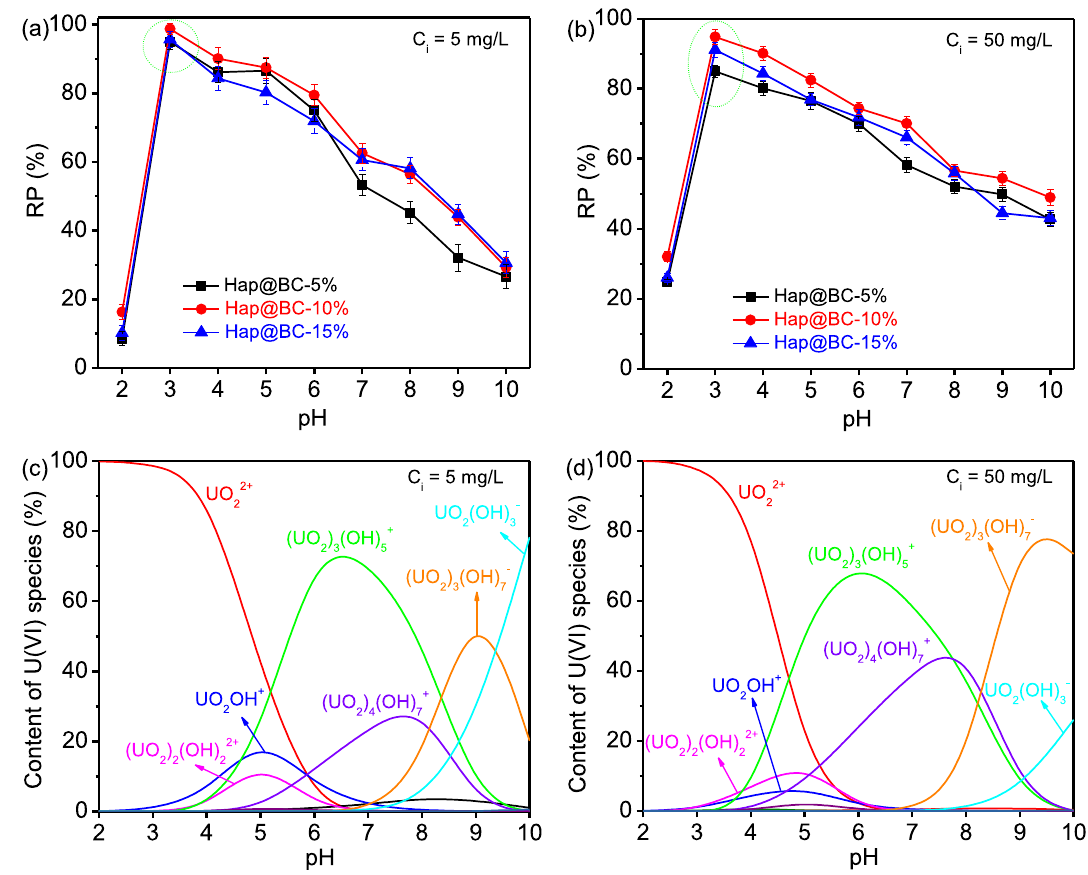
Fig. 2 a Effect of pH on U(VI) removal by Hap@BC-5%, Hap@ BC-10% and Hap@BC-15% (T = 298 K, m/V = 0.1 g/L and C i = 5 mg/L), b Effect of pH on U(VI) removal by Hap@BC-5%, Hap@BC-10% and Hap@BC-15% (T = 298 K, m/V = 0.1 g/L